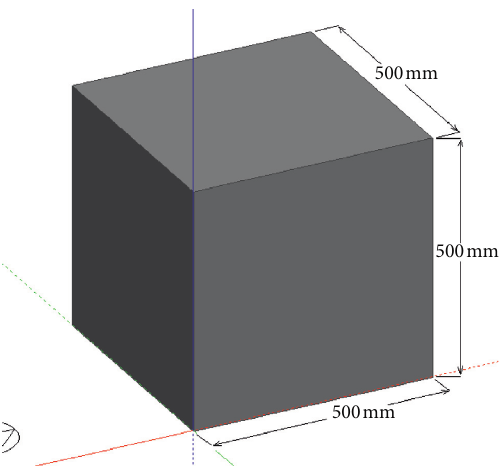
Figure 5: Simulation